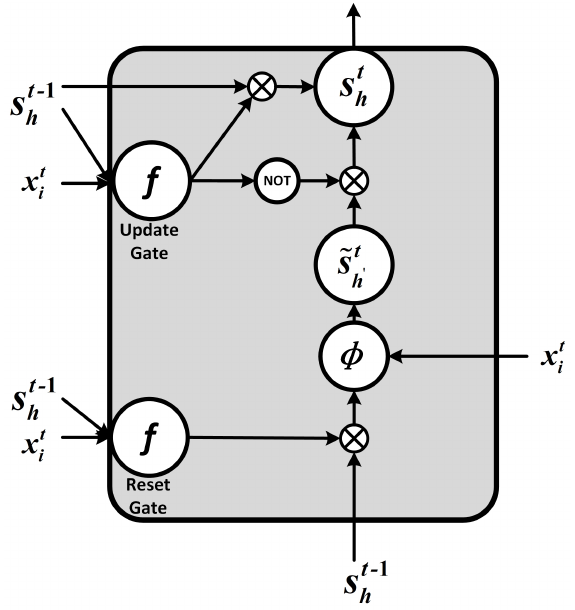
Figure 2. Inner structure of GRU, where all arrows represent the weights between gates and units and the units of f and φ are the activation functions. The parameters are explained in detail after the Equations